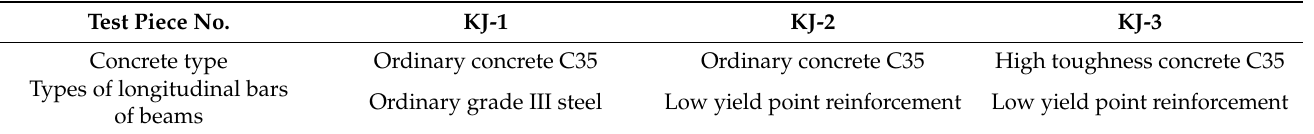
Table 1. Details of frame specimens.